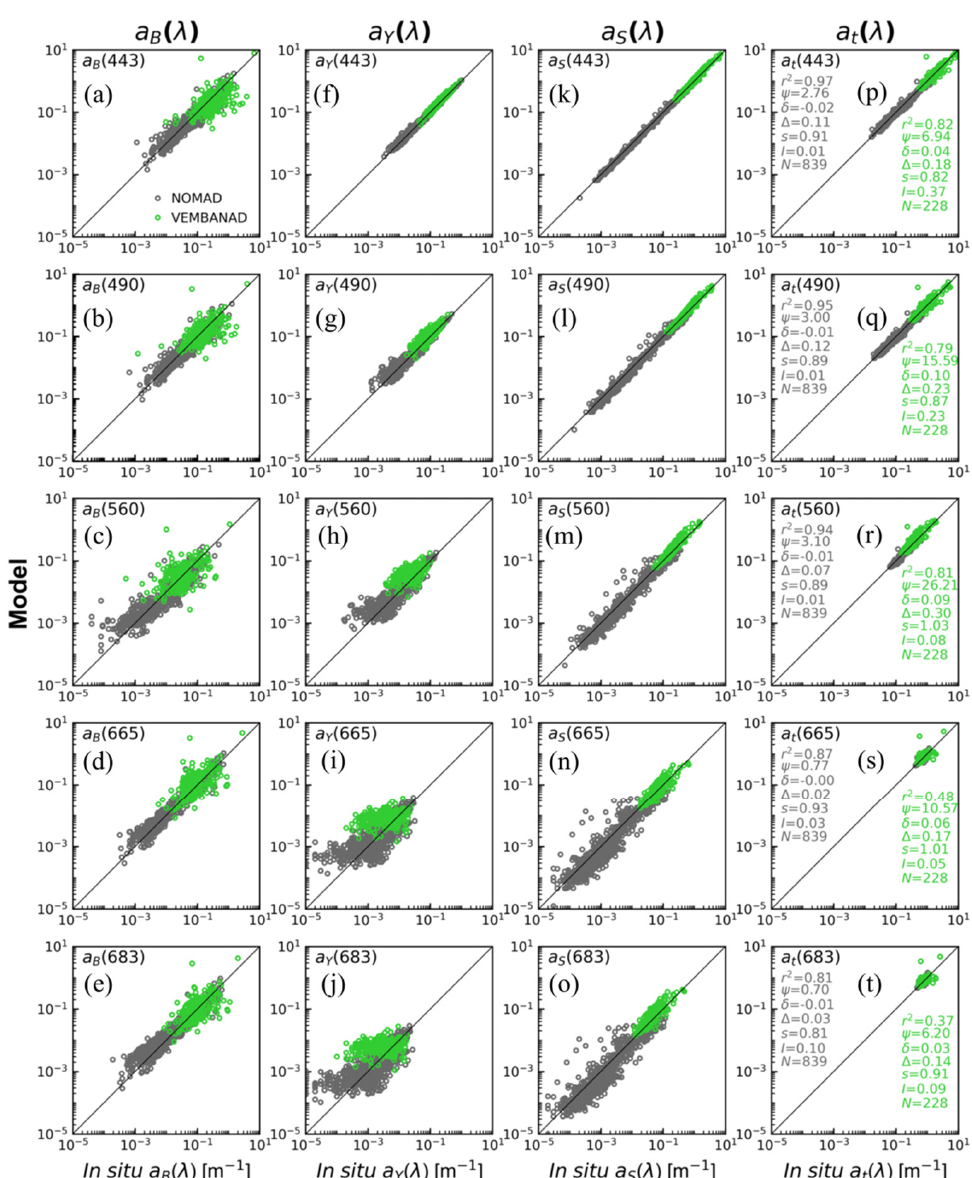
Figure 4. Comparison between the in situ and modelled absorption coefficients of phytoplankton ( a B , first column ), coloured dissolved organic matter ( a Y , second column ), non-algal suspended particles ( a S , third column ), and the sum of absorption by each of the constituents— B , Y , and S and water, W , ( a t , forth column ) at five key wavelengths—443, 490, 560, 665, and 683 nm using the VL (green circles, 𝑁 = 228 ) and NOMAD (grey circles, 𝑁 = 839 ) datasets.